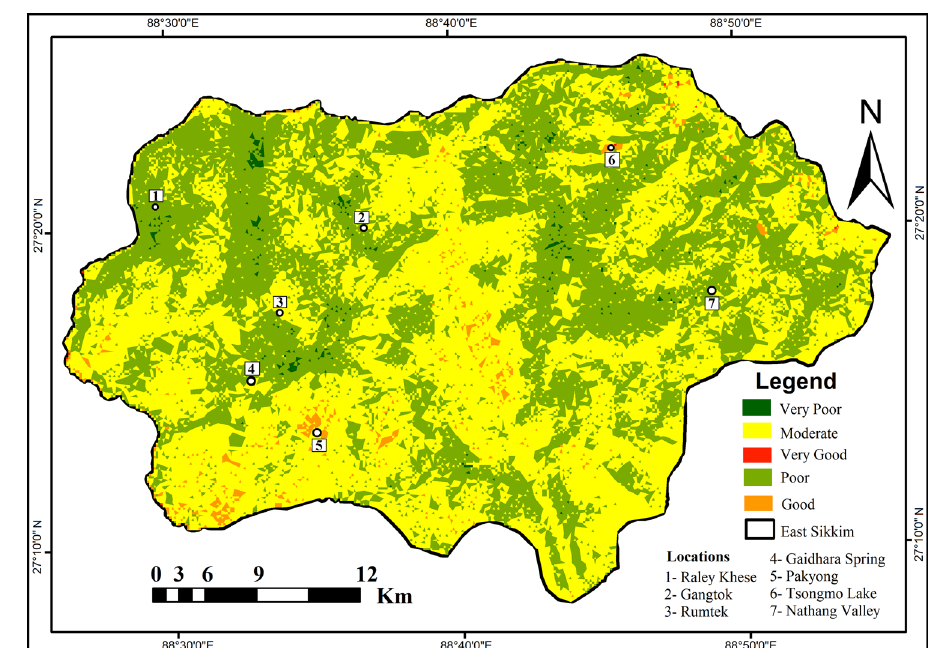
Fig. 12 Groundwater recharge potential map of East